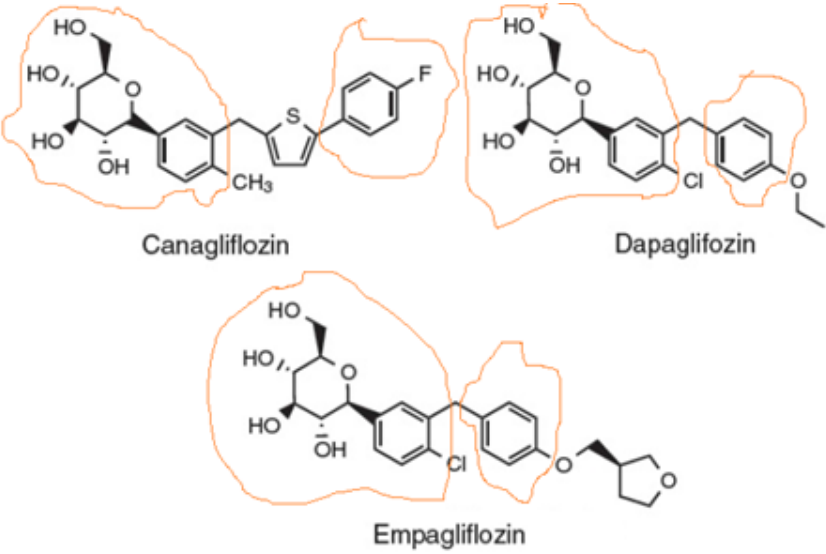
Figure 1. Structures of the three SGLT2 inhibitors currently carrying FDA-approved cardiovascular indications. The parts of the molecule that constitute the pharmacophore are designated as circled by orange lines.